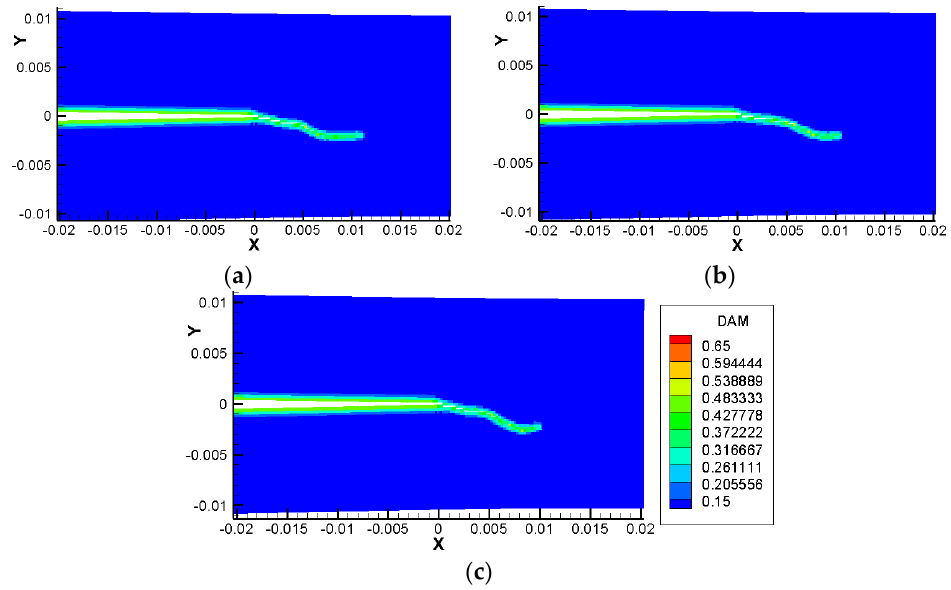
Figure 6. Crack path computed with different time step sizes for δ =1 mm, Δ x =0.25 mm and m = 4 at 80 µs: ( a ) Δ t = 10 ns; ( b ) Δ t = 20 ns, ( c ) Δ t = 25 ns.